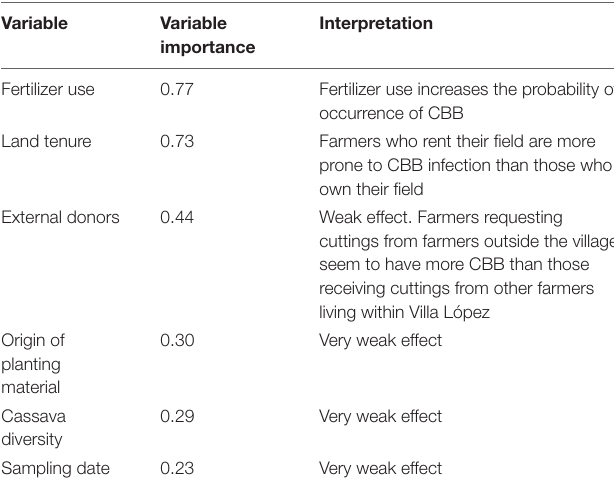
TABLE 2 | Sum of Akaike weights of the models for each